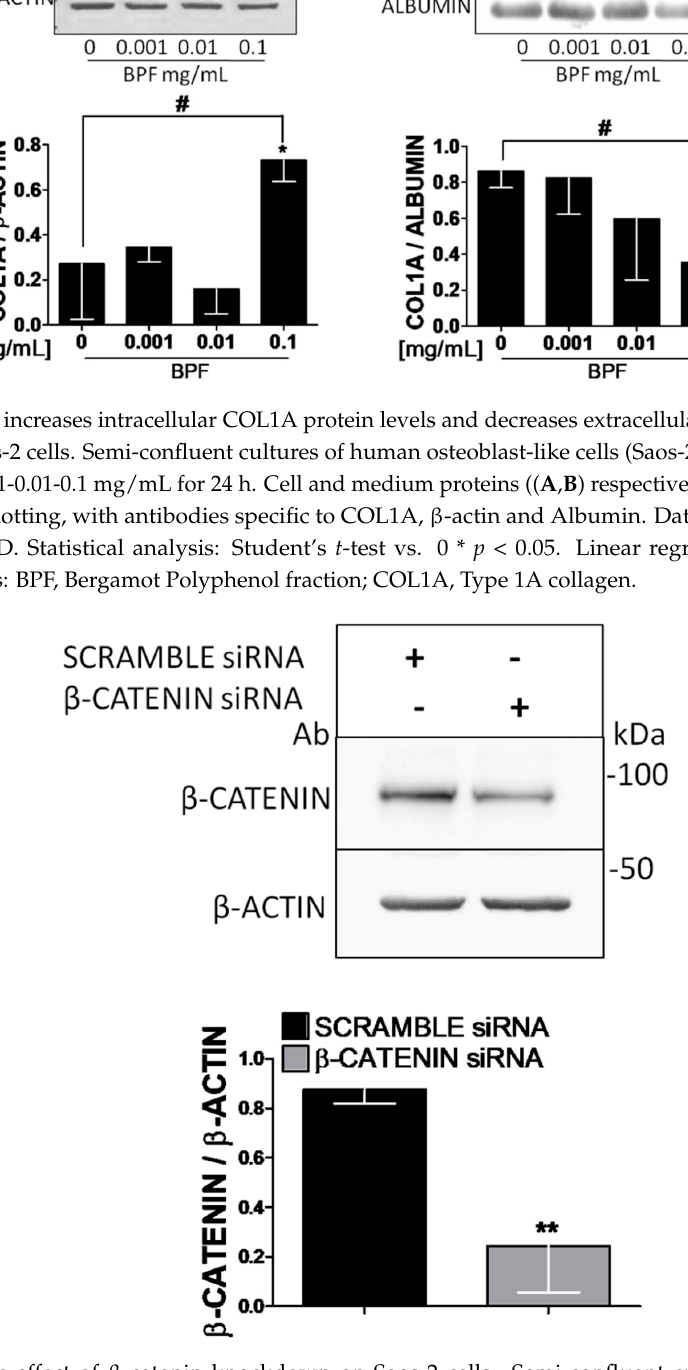
Figure 5. The effect of β -catenin knockdown on Saos-2 cells. Semi-confluent cultures of human osteoblast-like cells (Saos-2) were incubated with 10 nM β -catenin or scrambled siRNA for 48 h. Cell proteins were analyzed by Western blotting, with antibodies specific to β -catenin and β -actin. Data are represented as mean ± SD. Statistical analysis: Student’s t -test vs. scrambled siRNA ** p < 0.01. Abbreviations: BPF, Bergamot Polyphenol Fraction.